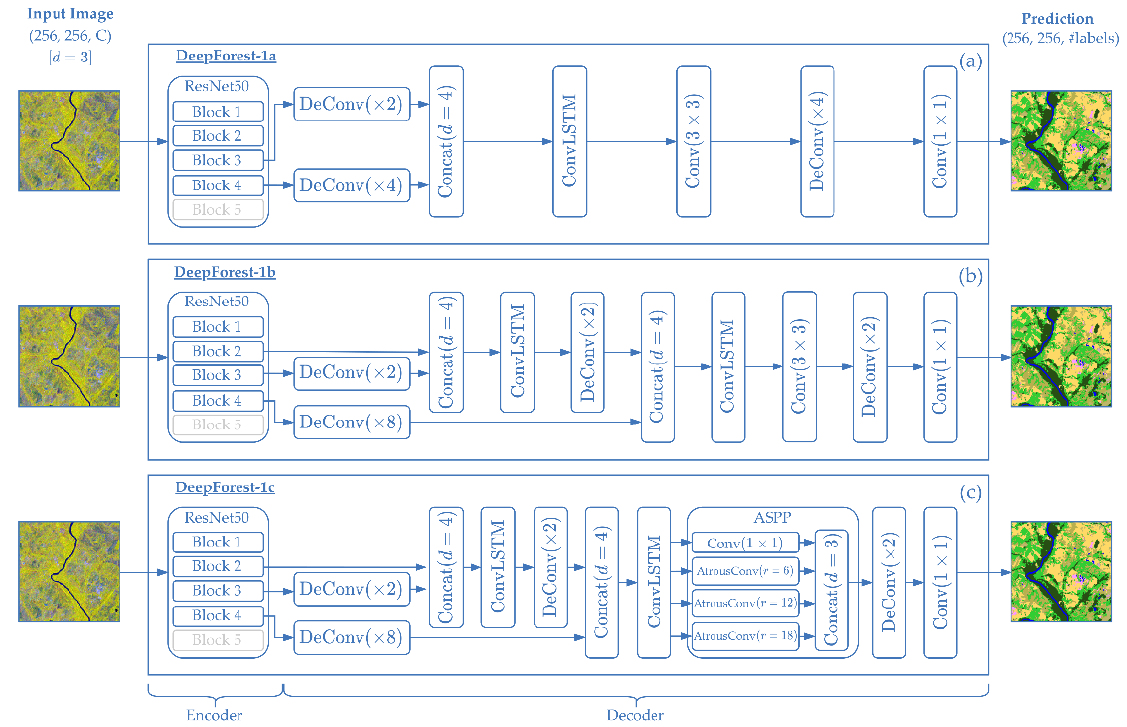
Figure 4. DeepForest variations: ( a ) DeepForest architecture with one ConvLSTM block (DeepForest ‐ 1a). ( b ) DeepForest architecture with two ConvLSTM blocks (DeepForest ‐ 1b). ( c ) DeepForest with an ASPP block (DeepForest ‐ 1c).